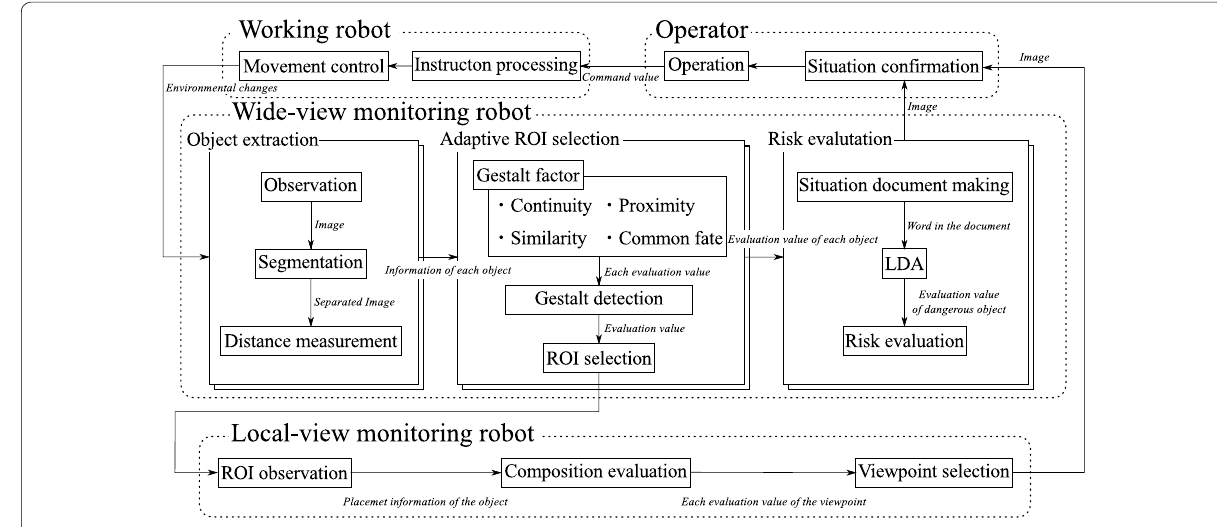
Fig. 1 Architecture of autonomous visual support